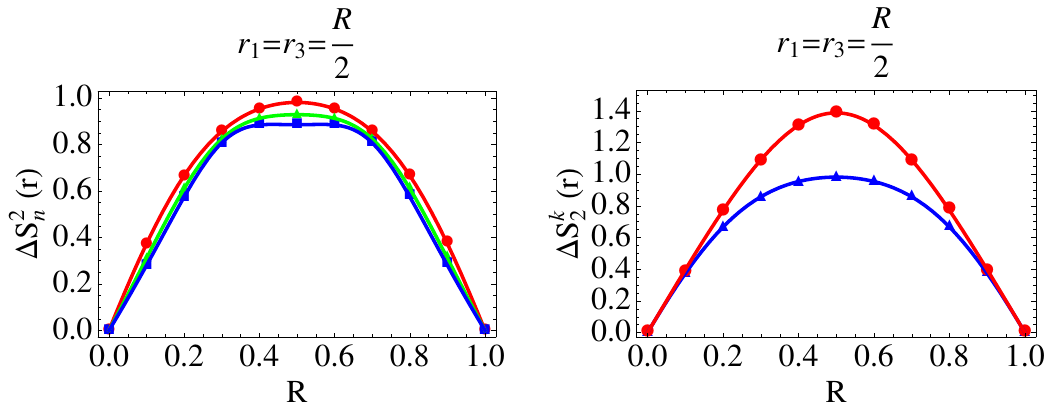
Figure 6 . Left: Numerical values of the 2nd (circles), 3rd (triangles) and 4th (squares) R(cid:19)enyi entropies for a state of two identical excitations with momenta for p 1 (cid:16) p 2 (cid:16) 4 (cid:25) . Right: Numerical values of the 2nd R(cid:19)enyi entropy of a state of two identical excitations (circles) and two distinct excitation (triangles). The momenta are p 1 (cid:16) p 2 (cid:16) 4 (cid:25) for identical excitations ( k (cid:16) 2) and p 1 (cid:16) 3 (cid:25) , p 2 (cid:16) 4 (cid:25) for two distinct excitations. In all cases agreement with the analytic results (continuous curves) is